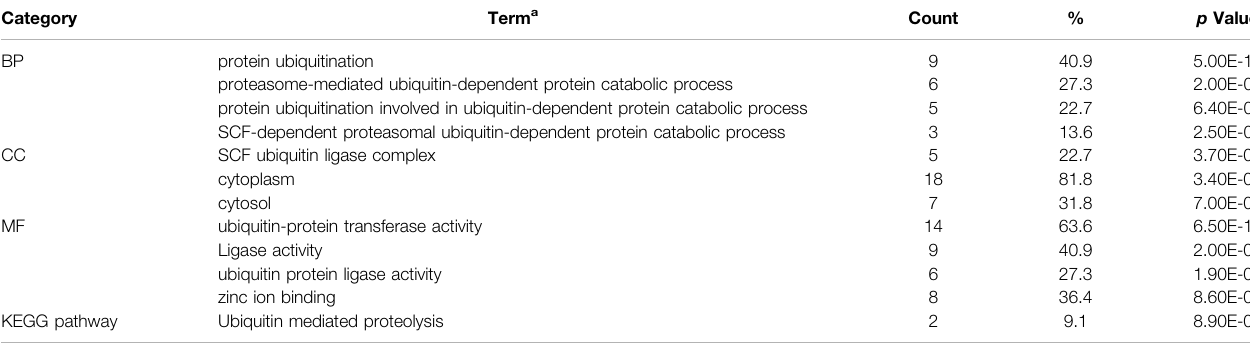
TABLE 1 | GO and KEGG pathway enrichment analysis of the signi fi cant module of upregulated DEGs. Category Term a